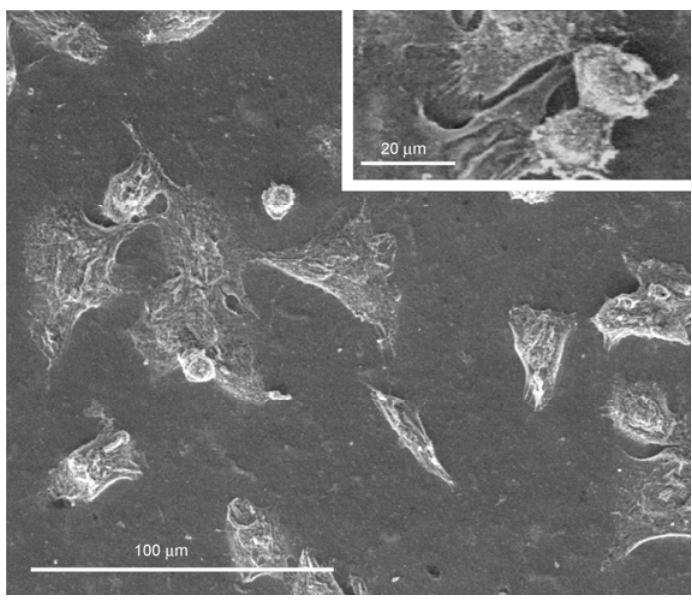
Figure 4. Environmental Scanning Electron Microscopy (ESEM) of J111 cells grown for 24 hours on collagen membranes